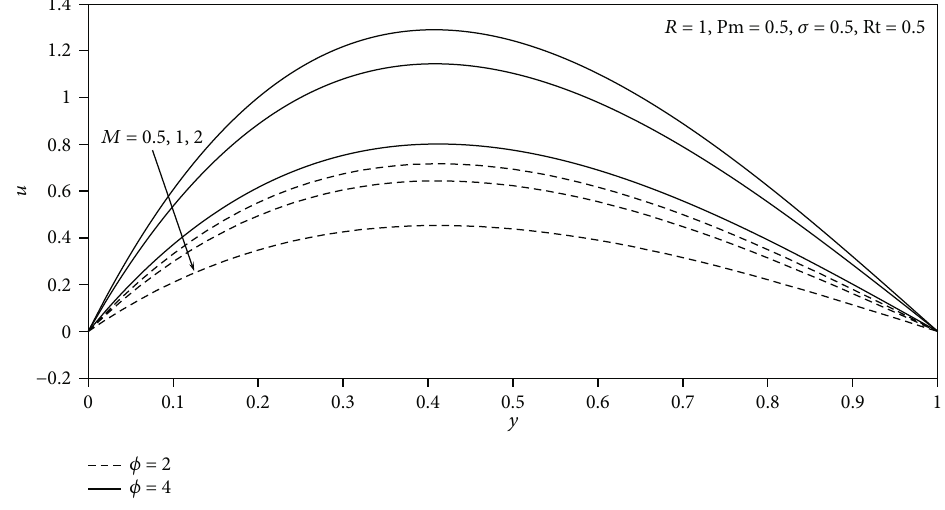
Figure 2: Velocity pro fi les for di ff erent values of M and ϕ .